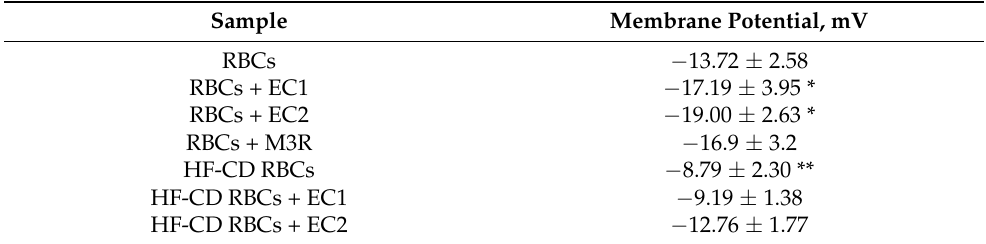
Table 3. Values of transmembrane potential calculated for control erythrocytes (RBCs) and these modified by 0.05 mg/mL of extracts form Cistus incanus L. (EC1 and EC2). RBCs collected from